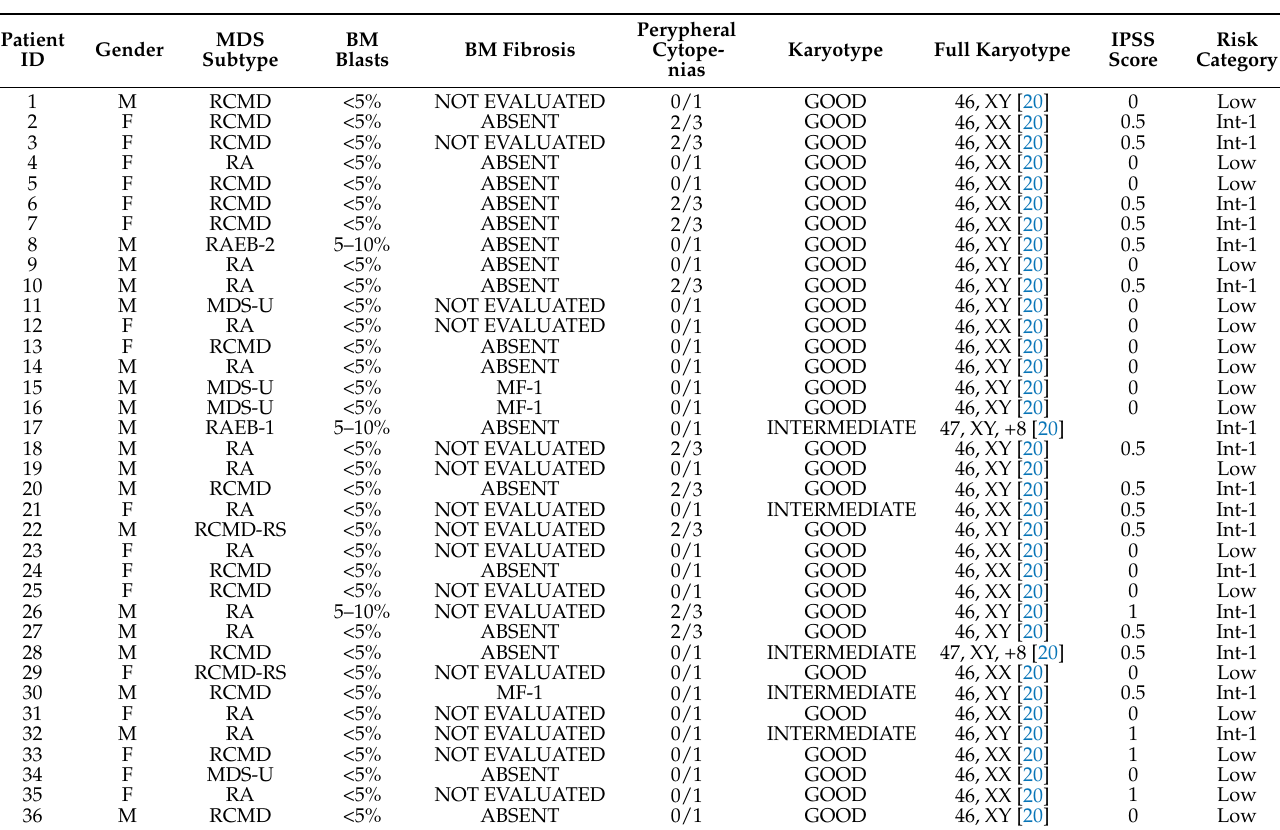
Table 1. Characteristics of the disease according to the patient enrolled and risk stratification.